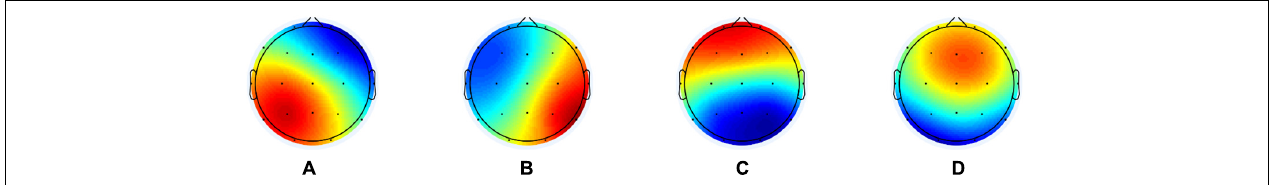
FIGURE 1 | The global maps that were calculated based the aggregated dataset from all participants and were back-fitted to each of the EEG recordings. The labels (A–D) are according to the previous literature in the microstate field.